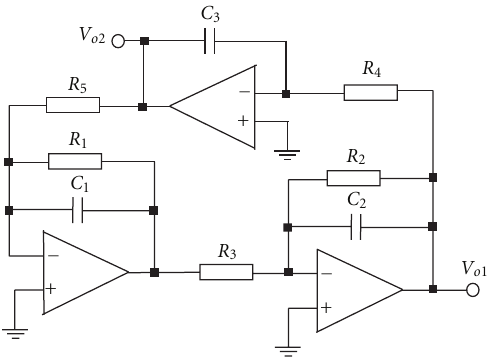
Figure 1: The first proposed quadrature oscillator circuit.